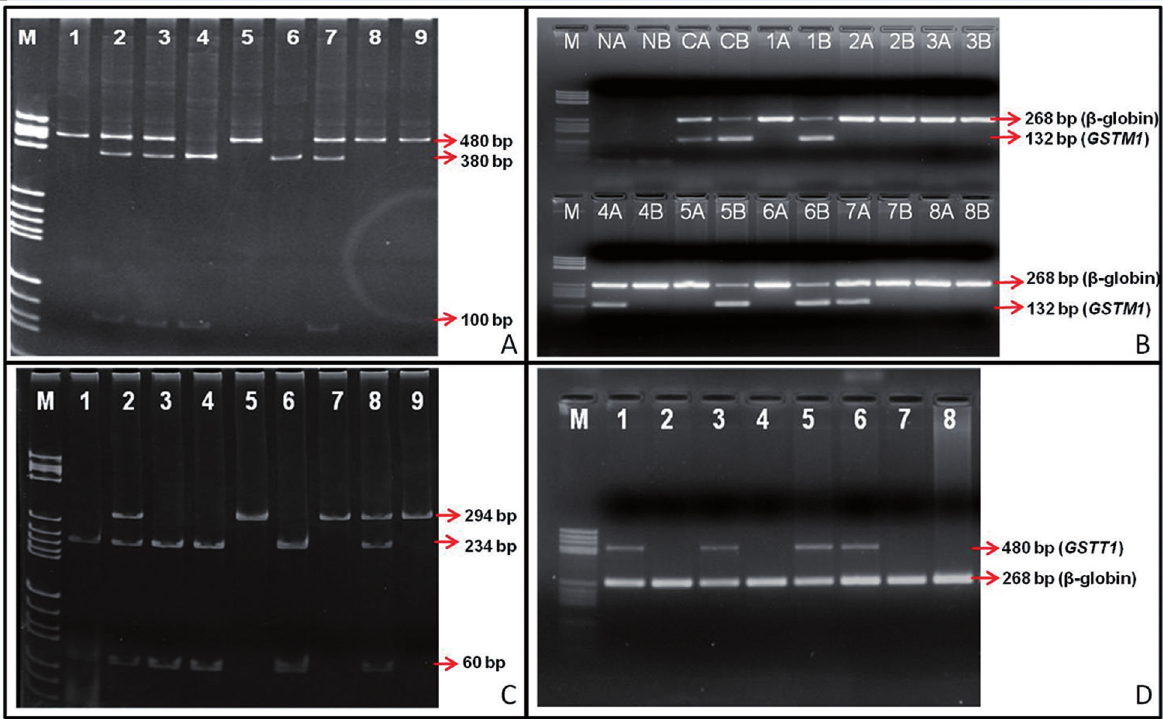
Figure 1 - Electrophoresis profile of polymorphisms GSTA1, GSTM1, GSTT1 and